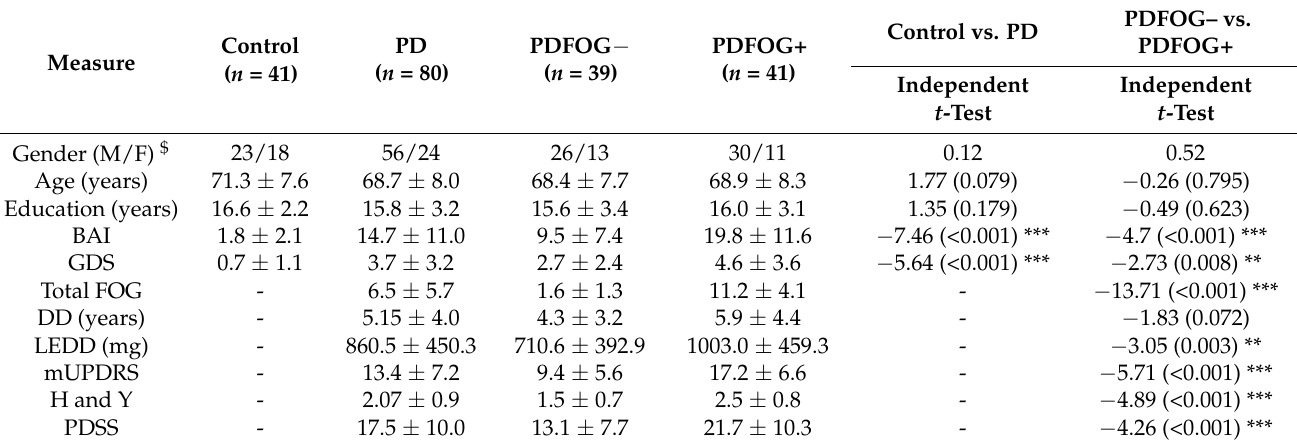
Table 1. Demographic and clinical assessments in controls vs. patients with